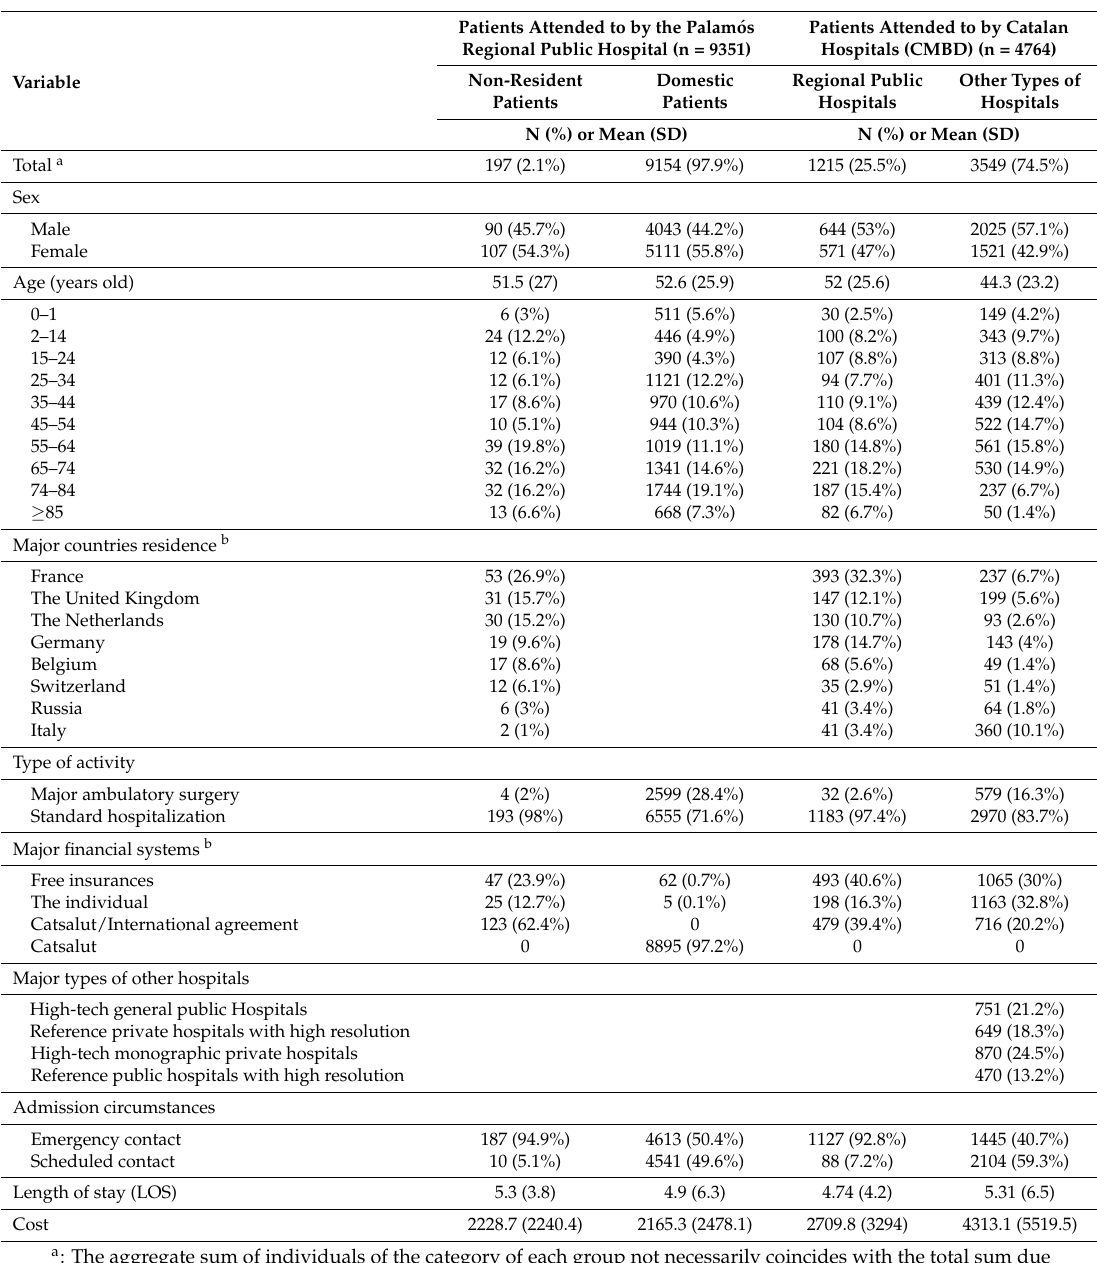
Table 1. Summary